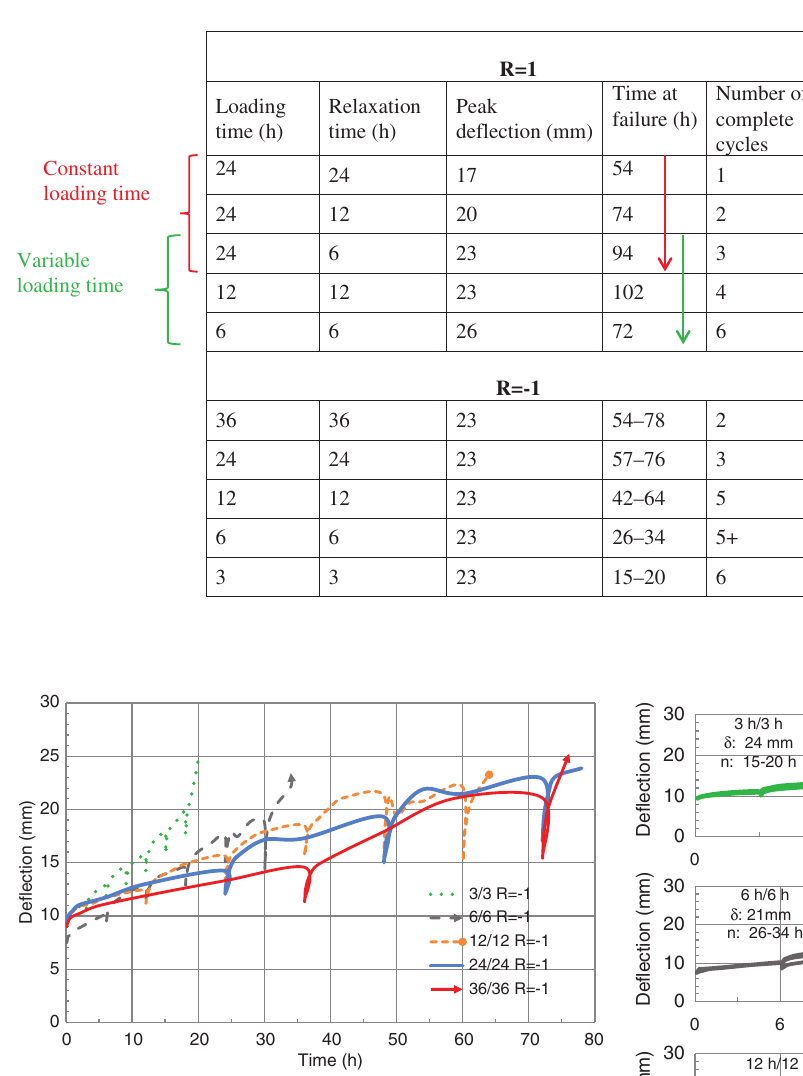
Figure 4: Typical R = -1 test results showing the dependence on the number of reversals.